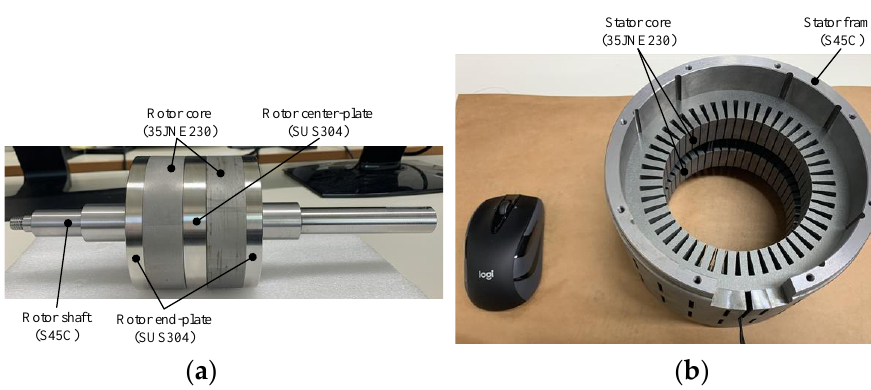
Figure 8. Configuration of prototype motor: ( a ) photograph of rotor; ( b ) photograph of stator.